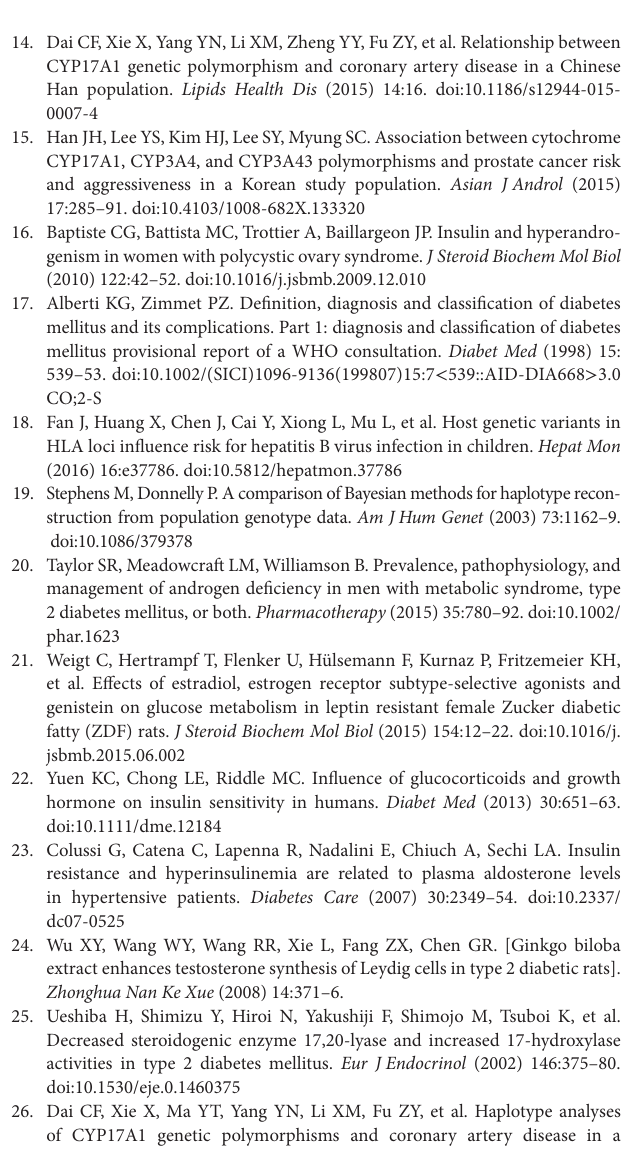
FigUre s1 | Linkage disequilibrium (LD) patterns between three genotyped single nucleotide polymorphism (SNPs). LD patterns between genotyped SNPs had shown among the 1,000 genome of Chinese Han population (a) , the diabetic group (B) , and control group (c)